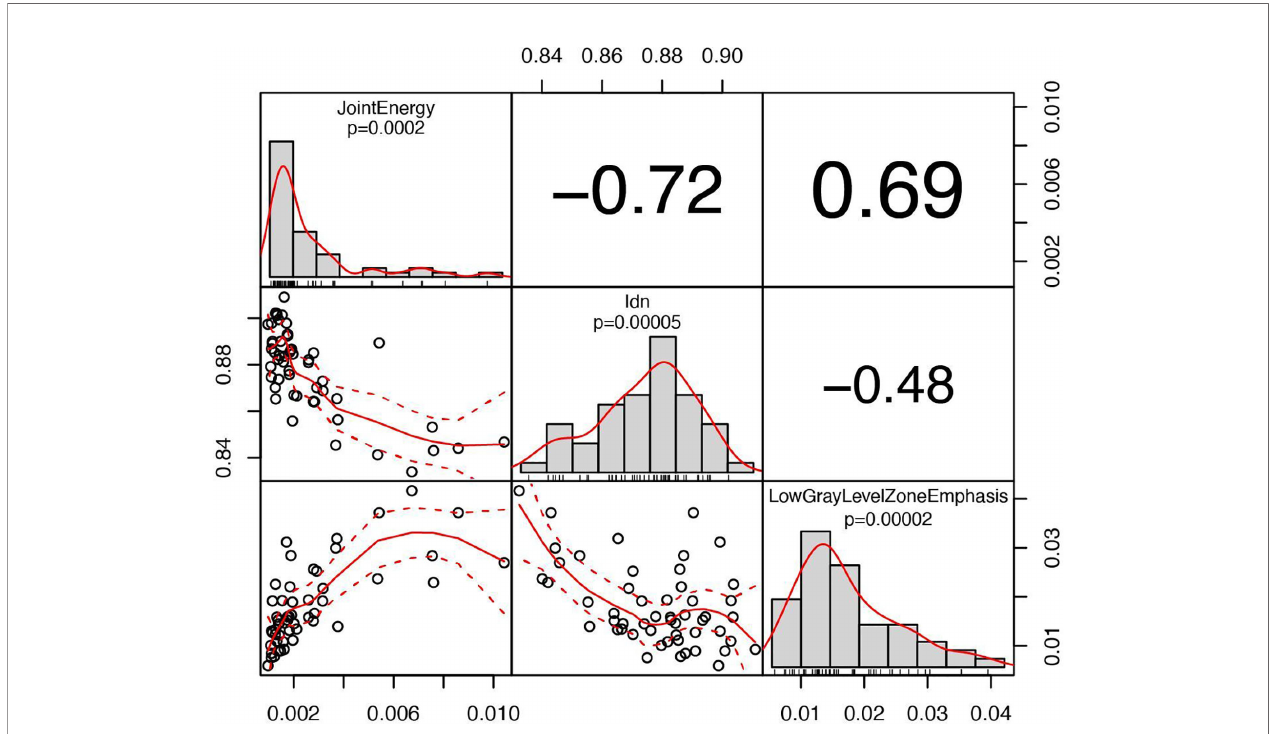
FIGURE 6 | Correlation chart between the selected radiomic features with a high signi fi cance for predicting patient response. The name of the feature, the signi fi cance level and the distribution are displayed on the diagonal. In the top triangular part, the absolute value of the Pearson ’ s correlation coef fi cient is reported. In the bottom, the bivariate scatterplot is visible together with the fi tted line according to a second order local polynomial